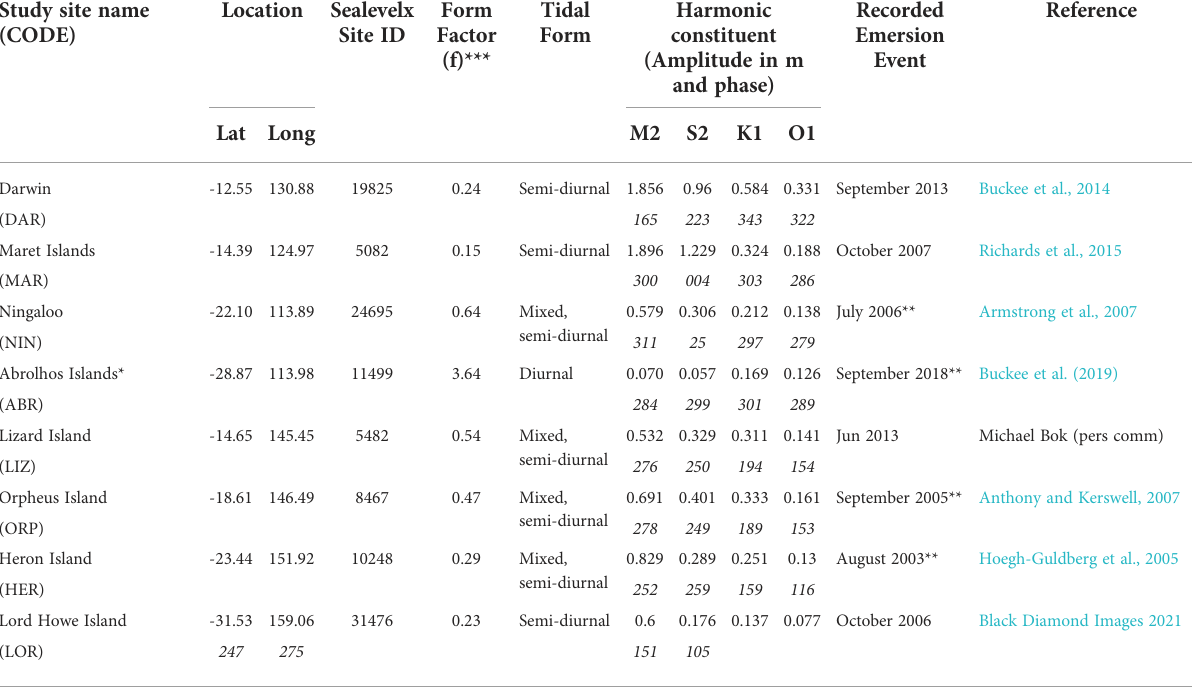
TABLE 1 Study sites coordinates, Sealevelx identi fi er (http://sealevelx.ems.uwa.edu.au), form factor (f) and harmonic constituents for the nearest Australian National Tide Tables (ANTT) port, and details of recorded emersion events used to estimate reef height